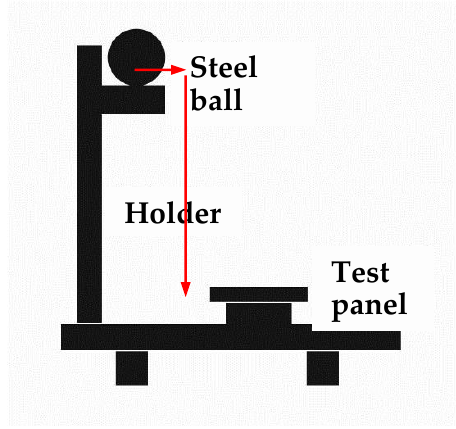
Figure 3. Schematic diagram of the ball drop test machine.